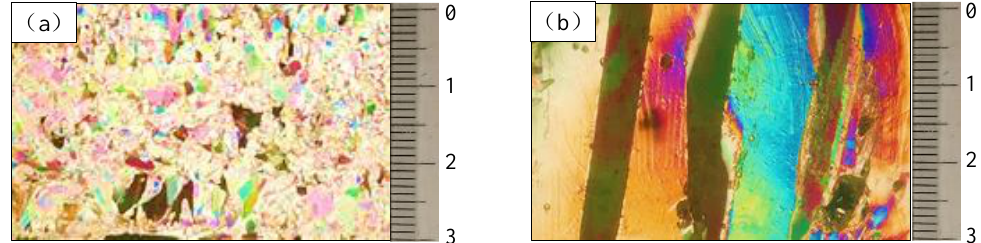
Figure 3. The crystals of the ice samples used in the experiments. ( a ) Yellow Sea ice ( b ) fresh-water ice.